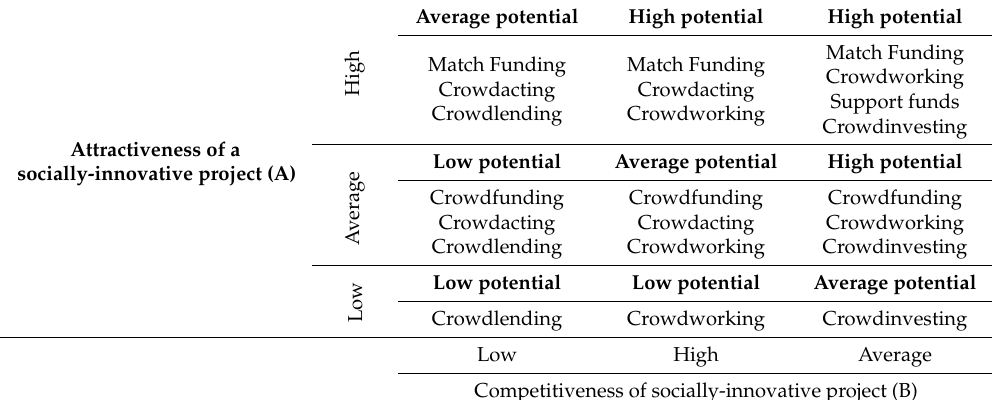
Table 3. Adapted McKinsey matrix taking into account shared economy